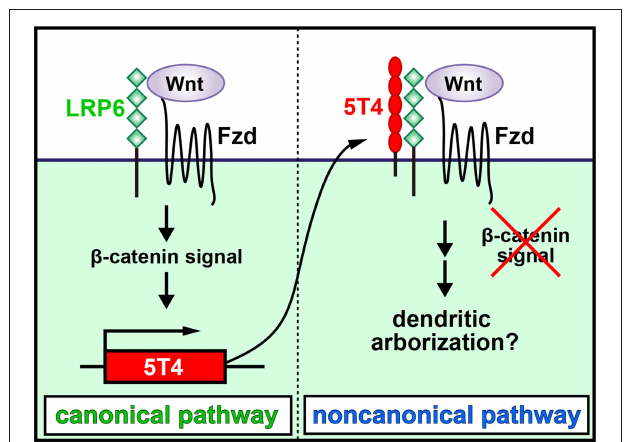
FIGURE 2 | Schematic diagram of dendritic development in newborn OB granule cells regulated by odor inputs. 5T4 leucine-rich repeat (LRR)-containing transmembrane protein is induced by and downregulates the Wnt canonical pathway. Neural activity may induce the production of a canonical Wnt ligand to upregulate 5T4 , which subsequently blocks the canonical pathway and favors the noncanonical pathway in OB interneurons by inhibiting the internalization of a Wnt-coreceptor, low-density lipoprotein receptor-related protein 6 (LPR6). This leads to facilitation of dendritic arborization in OB GCs (modified from Kagermeier-Schenk et al., 2011; Yoshihara et al., 2012).